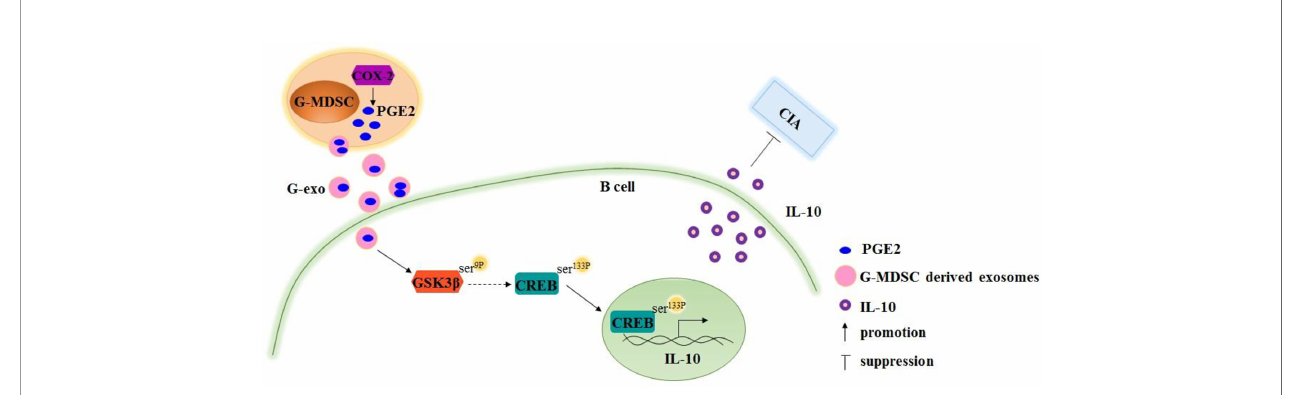
FIGURE 6 | Schematic image demonstrating that Granulocytic myeloid-derived suppressor cell exosomal prostaglandin E2 ameliorates collagen-induced arthritis by inducing IL-10 + B cells production via affecting GSK-3 b and